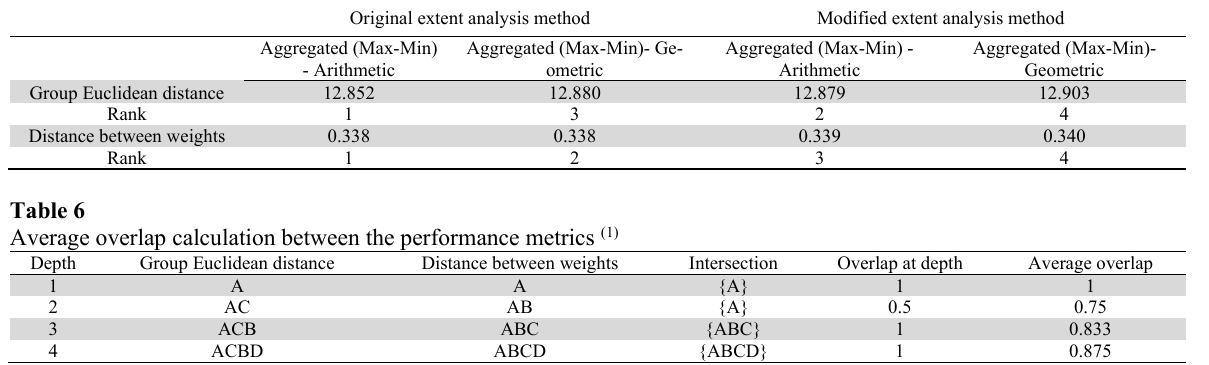
Evaluation metrics and associated rankings of the FAHP aggregation methods